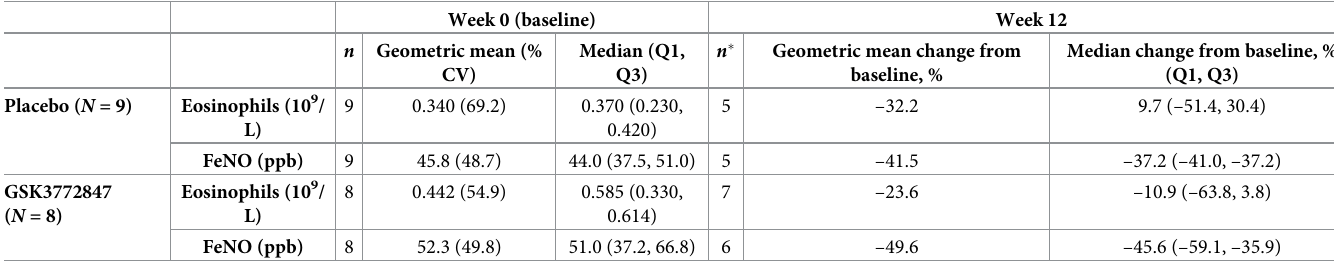
Table 2. Change from baseline to Week 12 in eosinophils and